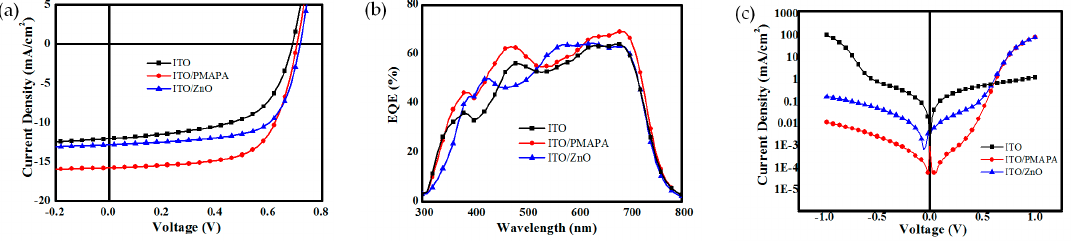
Table 1. Device performances of OSCs based on DMAPA-C 60 with different DMAPA-C 60 concentrations.